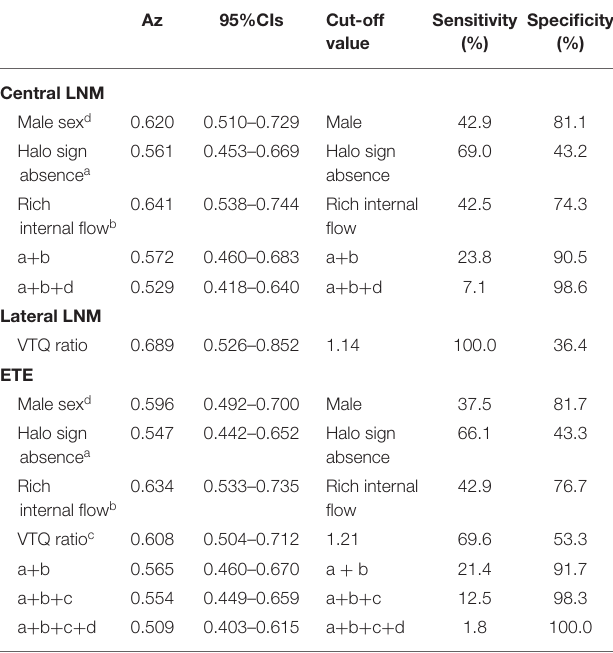
LNM, lymph node metastasis; CIs, confidence intervals; VAR, virtual touch tissue imaging area ratio; VTQ, virtual touch tissue quantification; ETE, extrathyroidal extension. a Represents halo sign absence. b Represents rich internal